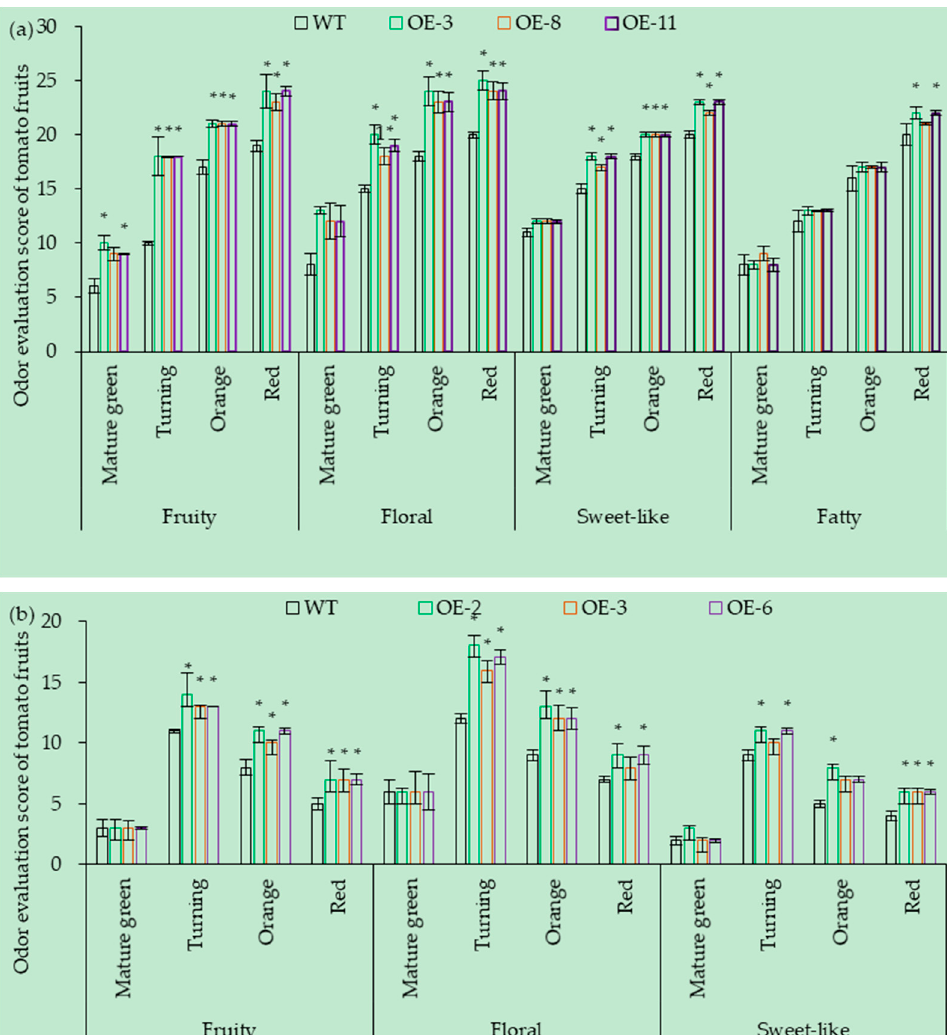
Figure 12. OE of SlCCD1A on the aroma scores of tomato fruits in ( a ) CI1005 and ( b ) TI4001. WT: pVbg2307 empty; * indicates that the aroma score was significantly higher in OE lines than in WT ( p < 0.05).